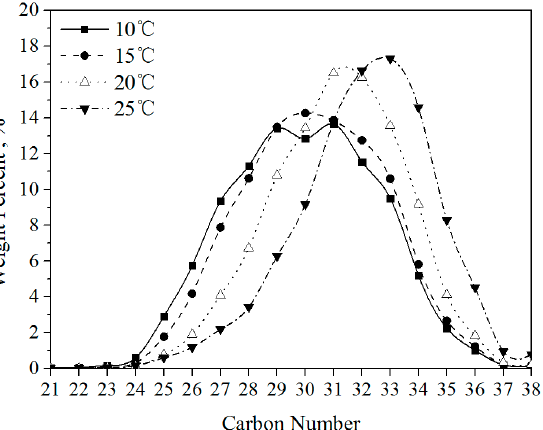
Figure 9. The carbon number distribution of precipitated wax at 25 °C, 20 °C, 15 °C and 10 °C for 15% artificial oil.